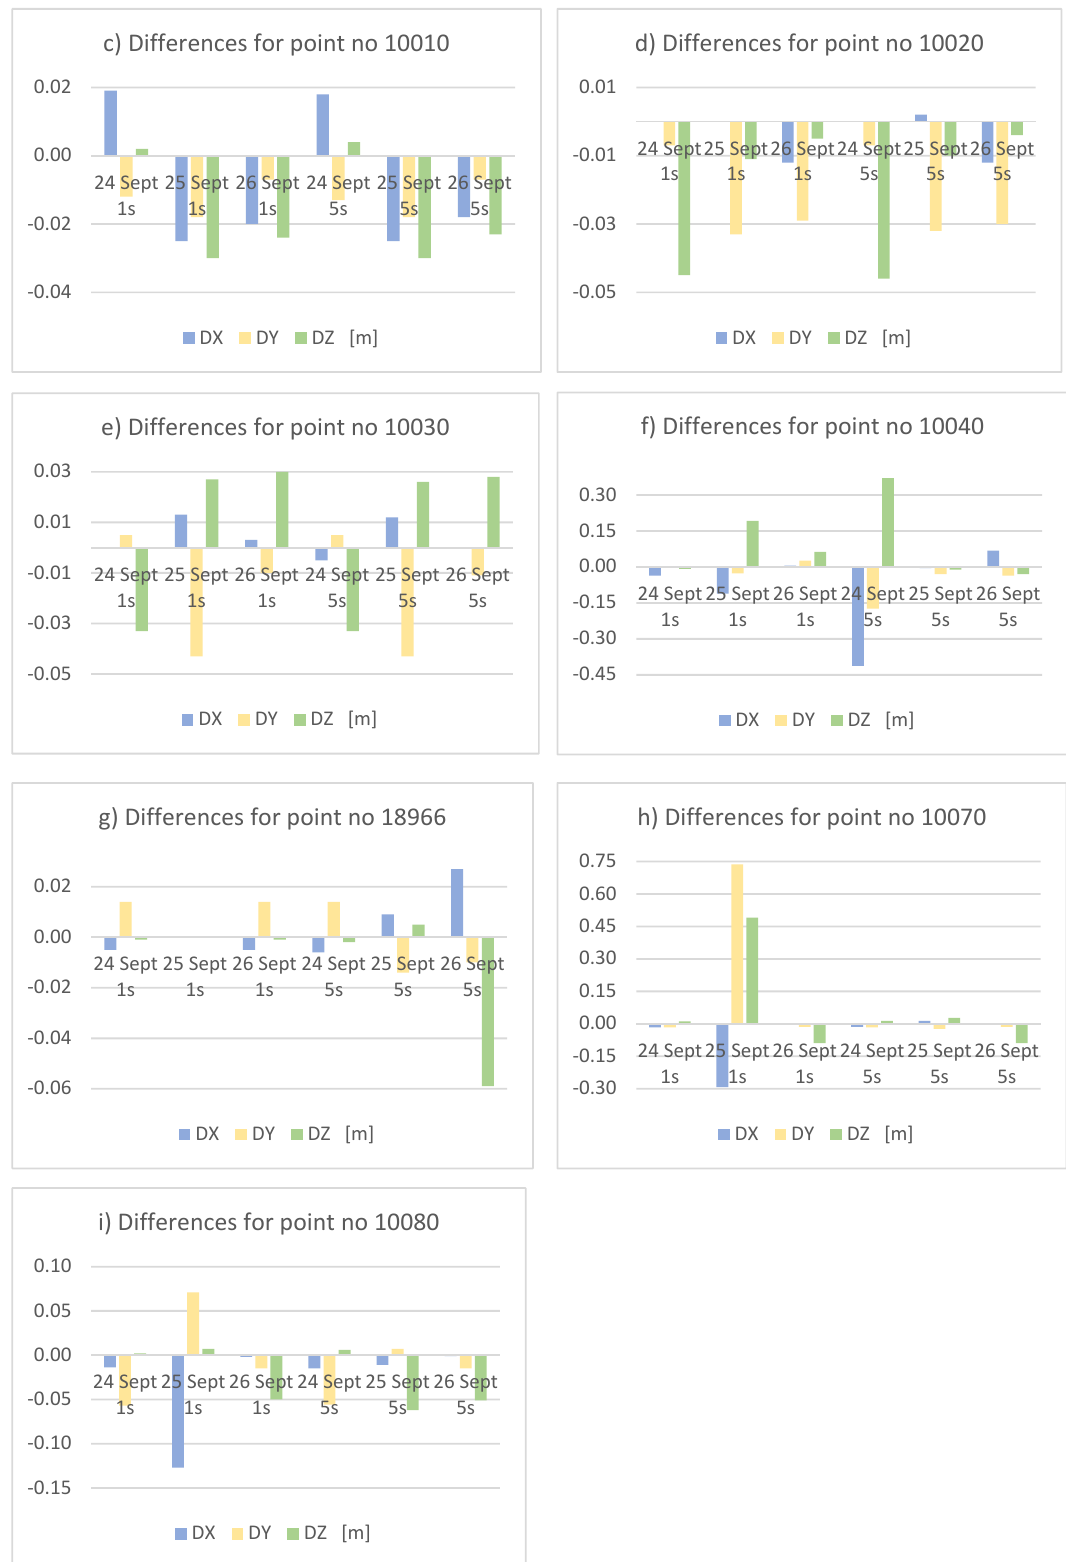
Figure 3. Differences of coordinates between reference coordinates from model static GNSS occupa- tion and rapid static surveys (in subfigures a – i are presented differences in meters with commas as decimal